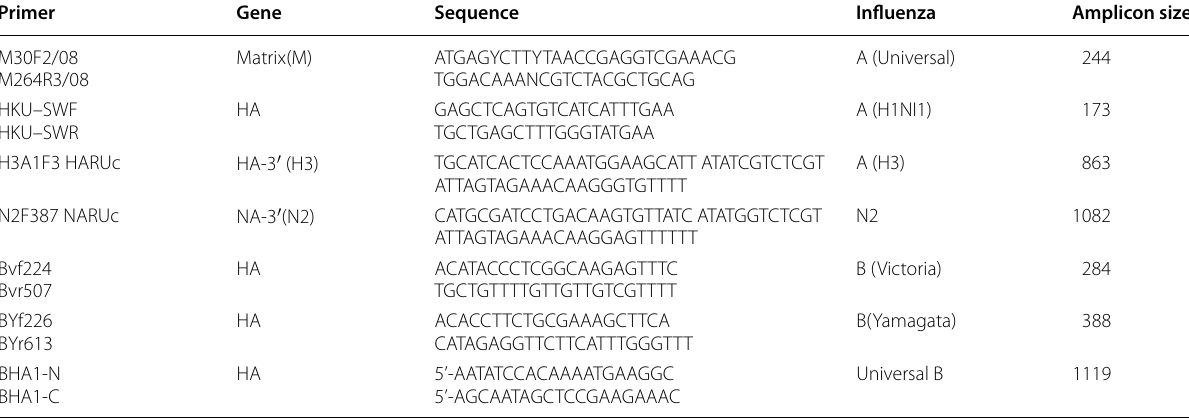
Table 1 PCR primers used in the study Primer